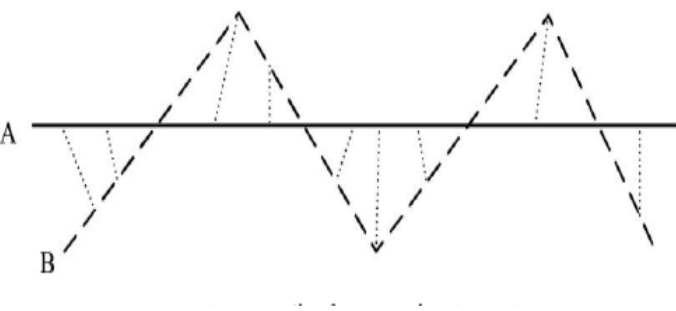
Figure 1. Typical structure diagram of convolutional neural network.